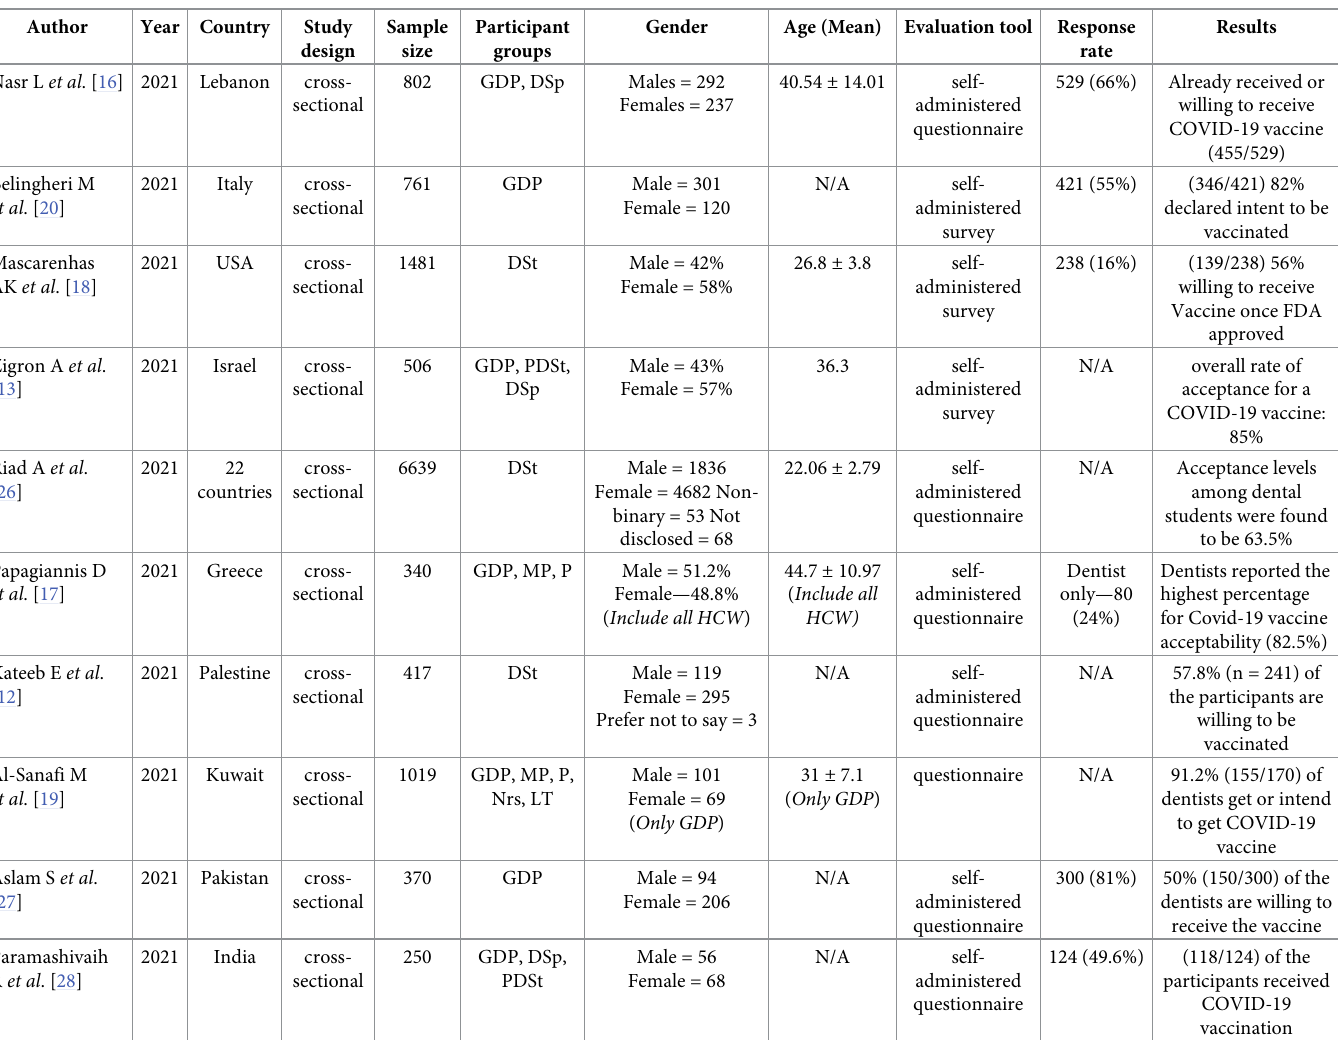
Table 1. Characteristics of the included